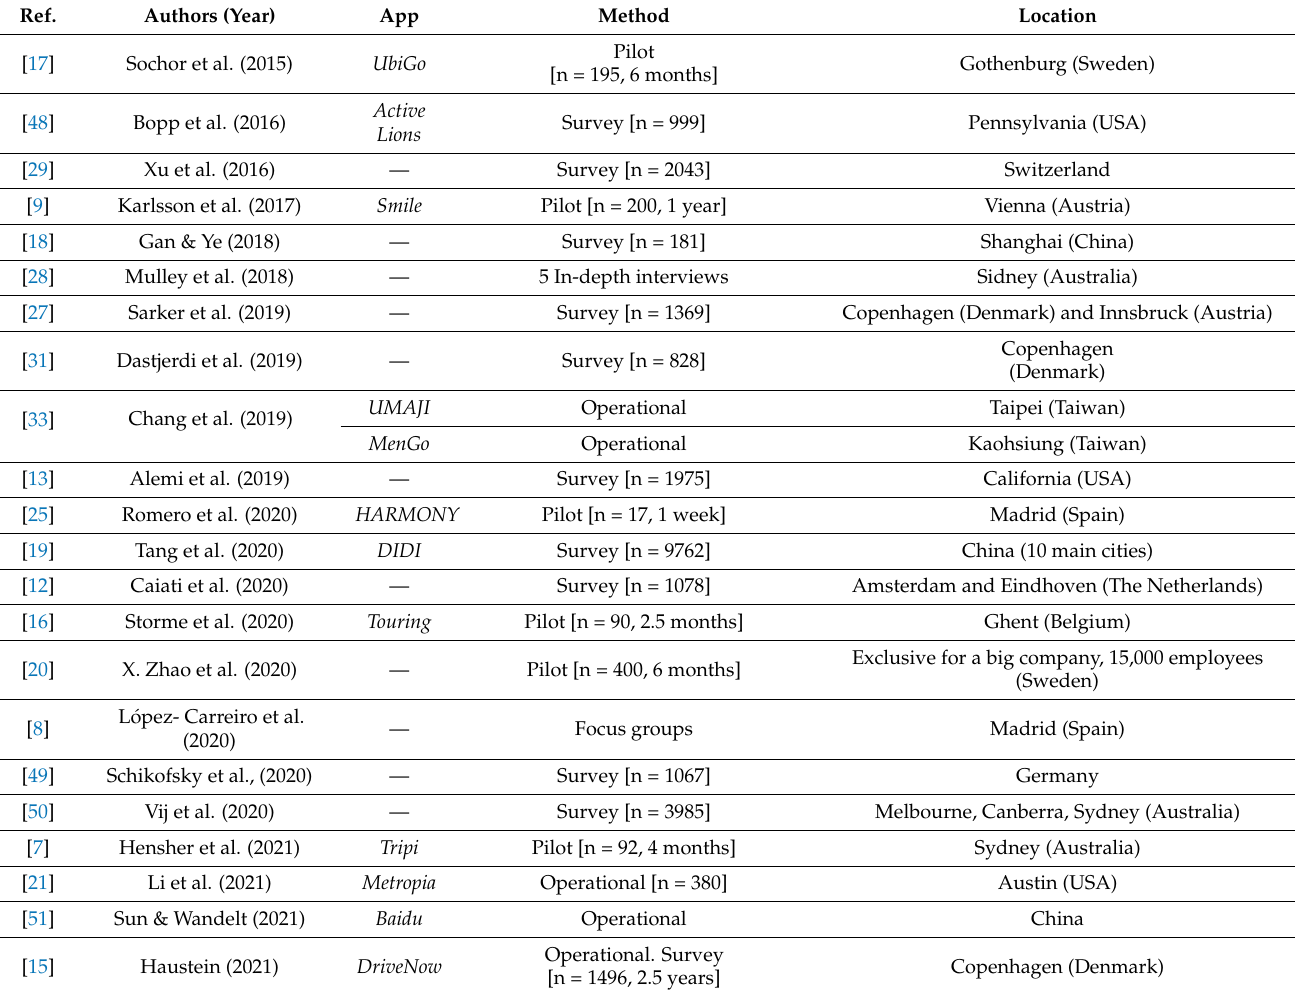
Table A1. Empirical studies on urban travel